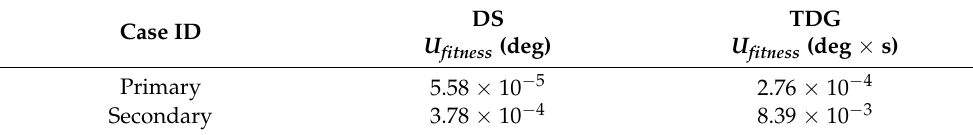
Figure 7. Aeroelastic response of the target node of the uncontrolled antenna structure under the operational cases. PSD modelled with the DS for the ( a ) primary and ( b ) secondary scenarios. TDG for the ( c ) primary and ( d ) secondary scenarios. Table 2. Evaluation of the fitness function for the uncontrolled antenna